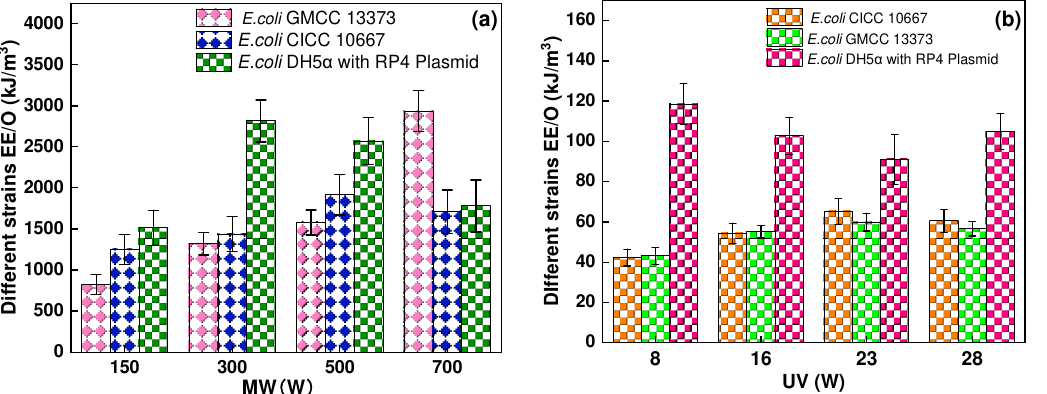
Figure 7. EE/O of various strains of E. coli (GMCC13373), E. coli (CICC10667), and E. coli DH5α with RP4 plasmid under ( a ) MW irradiation at different power outputs (150, 300, 500, and 700 W), ( b ) UV irradiation at various power outputs (8, 16, 23, and 28 W) at 20 s irradiation time.